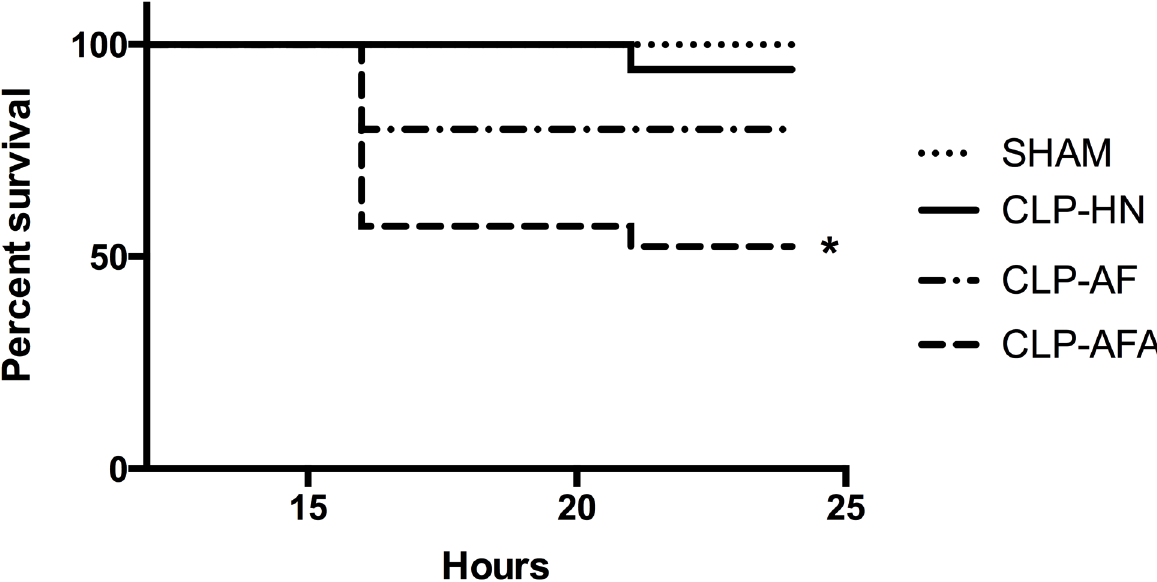
Fig 2. Survival of SHAM and septic rats (CLP-HN, CLP-AF and CLP-AFA) treated with different enteral nutrition formulations: Peptamen 1 HN (HN), Peptamen 1 AF (AF), Peptamen 1 AF enriched with arginine (AFA). * p < 0.05 vs. all the other groups. n = 5, 12, 15 and 21 rats in SHAM, CLP-HN, CLP-AF and CLP-AFA groups